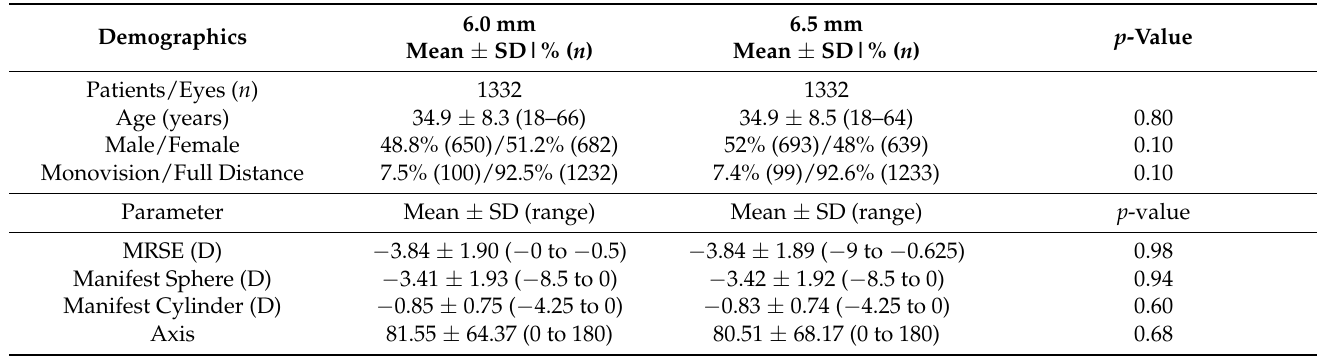
Table 1. Preoperative baseline characteristics.